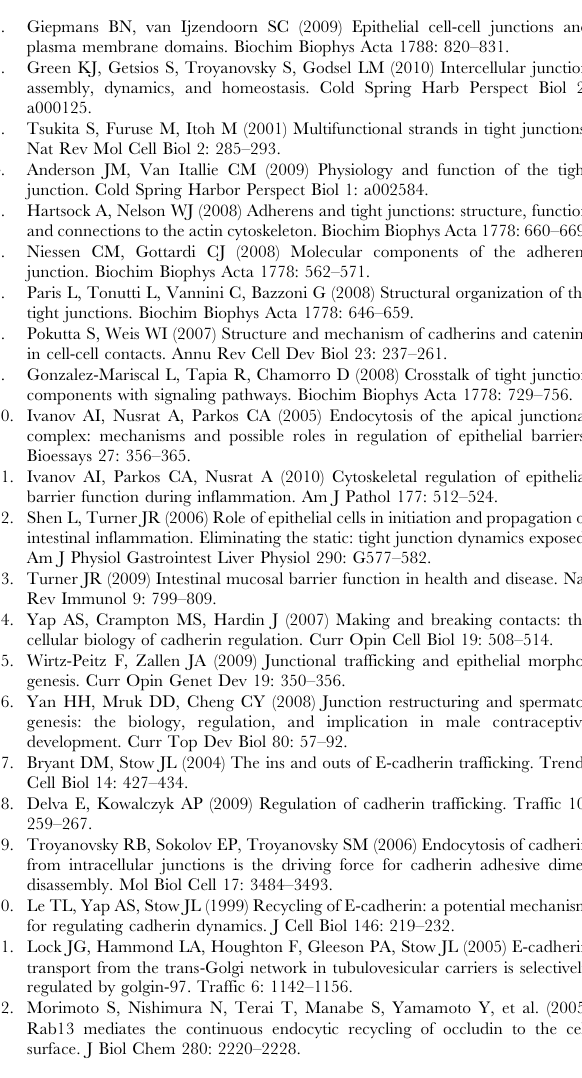
Figure S2 Overexpression of p120 catenin does not prevent junctional disassembly in a SNAP-depleted cells. ( A ) Immunoblotting analysis shows preserved p120 catenin level in p120-3 overexpressing SK-CO15 cells after a SNAP depletion. However, such p120-3 overexpression does not prevent disrup- tion of the paracellular barrier ( B ) and disassembly of AJs and TJs ( C, arrows ) in a SNAP-depleted epithelial cells; # p , 0.01 compared to the control siRNA-treated group (n = 3). Scale bar, 20 m m. Figure S3 Downregulation of a SNAP impairs glycosyla- tion and plasma membrane delivery of b 1 integrin. ( A ) SK-CO15 cells were transfected with either control or two different a SNAP duplexes (D1 and D2). Immunoblotting analysis shows the increased intensity of the lower band of b 1 integrin in a SNAP-depleted cells that corresponds to its nonglycosylated form. ( B ) Immunofluorescence labeling shows plasma membrane localization of b 1 integrin in control cells (arrows) and intracellular accumulation of this protein on day 4 of a SNAP knockdown (arrowheads). The lower panel of images presenting a dual immunolabeling with rat b 1 integrin antibody and control rabbit